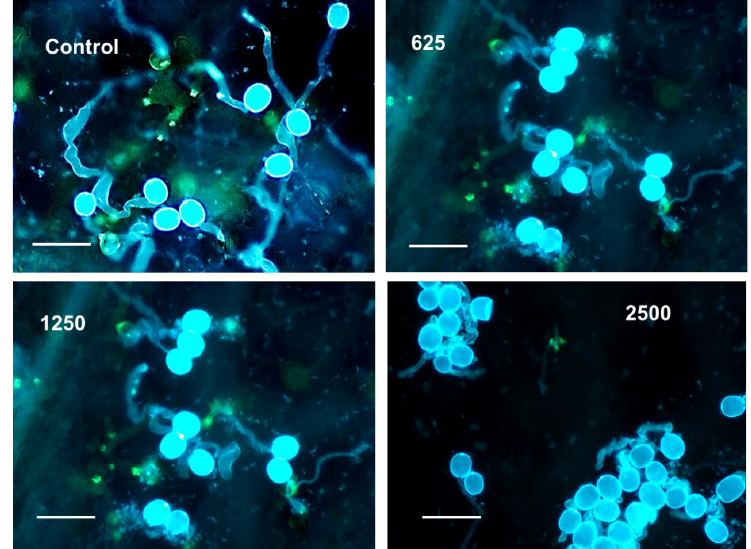
Figure 2. Fluorescence micrographs showing the effect of formulated TTO (625, 1250, and 2500 µg/mL a.i.) on germination and penetration of B. lactucae into lettuce leaves. Conidia and germ tubes fluoresce blue; infection structures inside the leaf fluoresce yellow. Bar = 50 µm. Photos were taken at 2 d after inoculation. Agronomy 2020 , 10 , x FOR PEER REVIEW